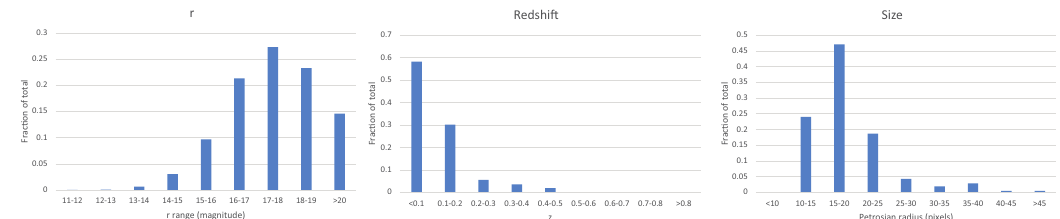
Figure 2. Distribution of the redshift, r magnitude, and Petrosian radius measured on the r band of the 115,359 galaxies that have spectra. These galaxies were used for training and testing the photometric redshift